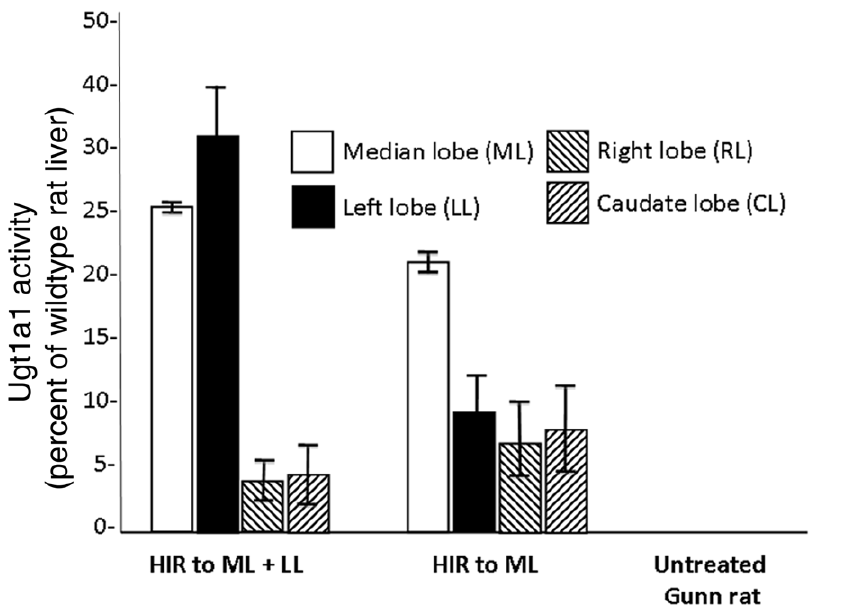
Figure 6. Ugt1a1 activity toward bilirubin in Gunn rats that received conformal HIR before hepatocyte transplantation. Ugt1a1 activities in liver homogenates of different recipient groups as in Figure 2 are shown (means 6 SD) as percent of the activity in the liver of Wistar-RHA rats (2.6 m mol/g liver per hour).